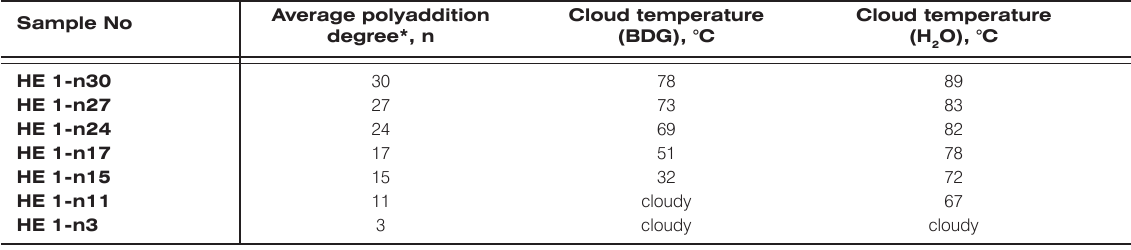
Table 2. Cloud temperature characteristics of the ethoxylated 2,2,4-trimethyl-1,3-pentanediol mono-isobutyrate (C12 hydroxyester) in relationship to their average polyaddition degree. Sample No